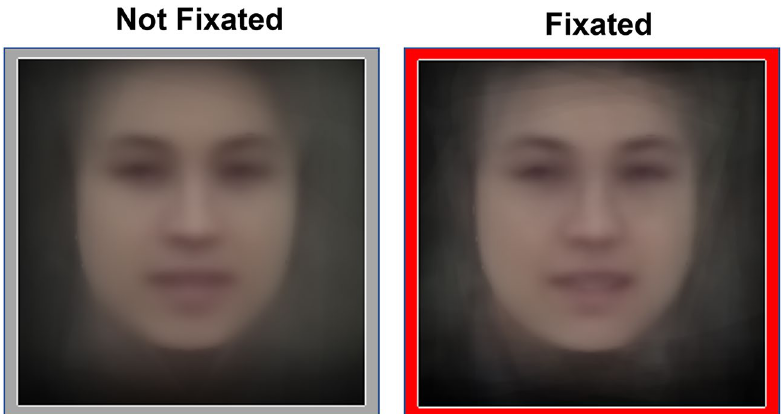
Figure 5. Image averages showing fixated and non-fixated views of the same faces. Average images of fully detected faces that were not fixated (left) and fixated (right) across all participants. This method is shown here for an illustration of what is achievable using our approach but is not intended as formal analysis. A map showing the locations of face images that contributed to these averages in the field of view is shown in Fig. S4 of Supplementary